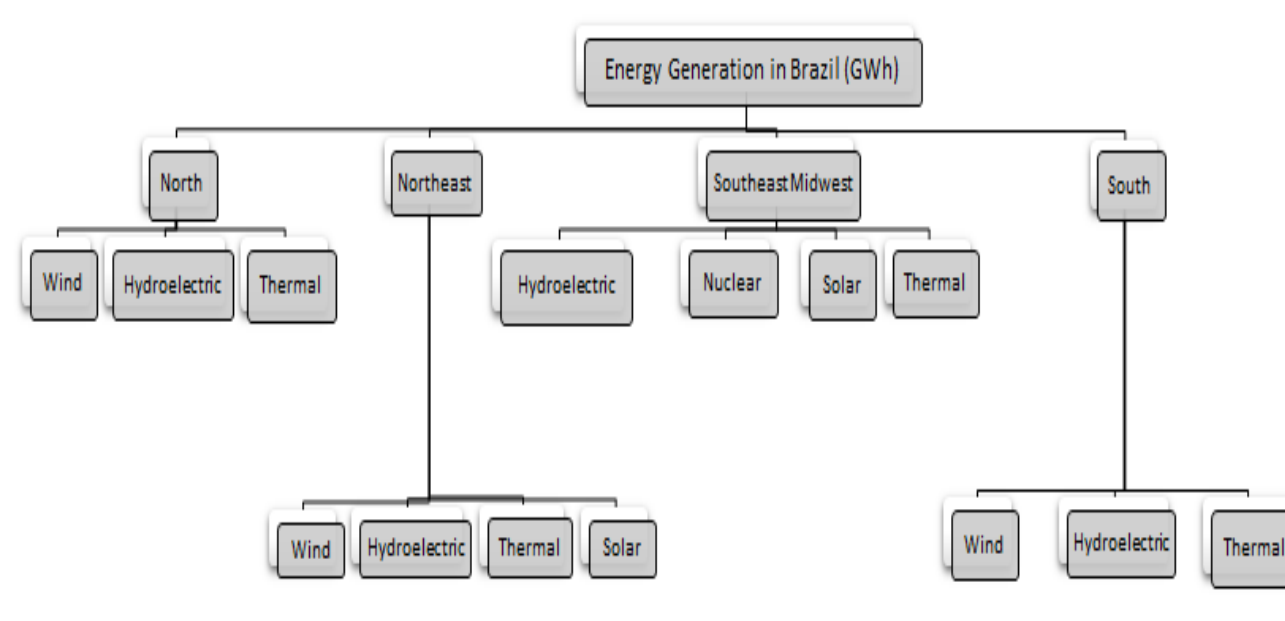
Figure 7. The Brazilian power generation system.